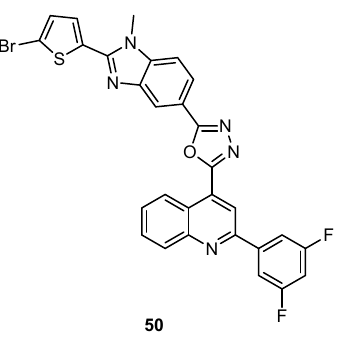
Figure 23. Dabigatran and its analog structures.